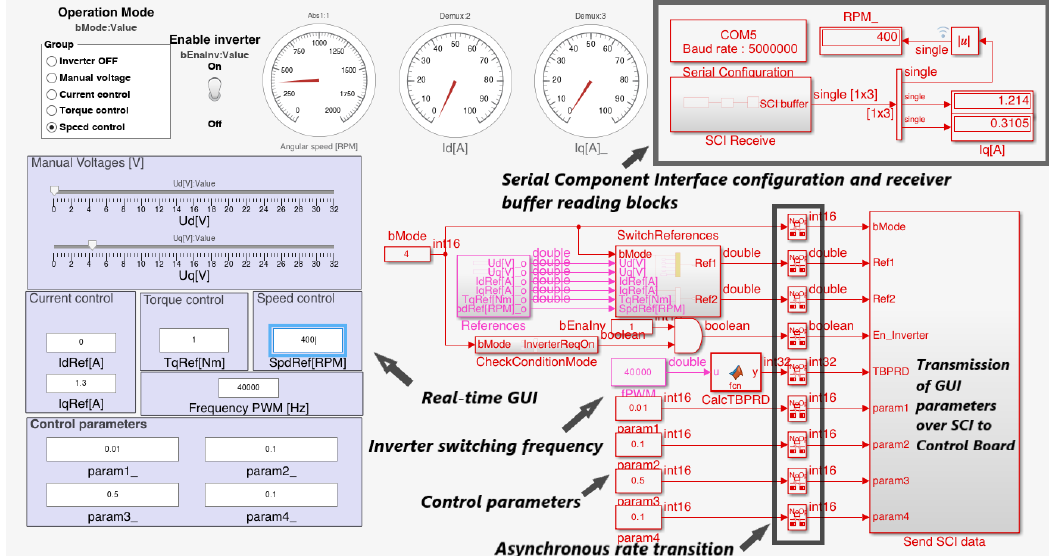
Figure 5. View of the real-time SCI interface GUI implemented in